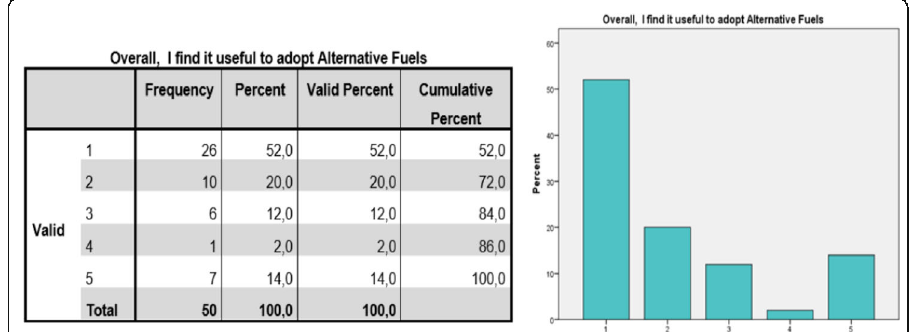
Fig. 9 Participants find the adoption of LNG and electricity useful. Source: by